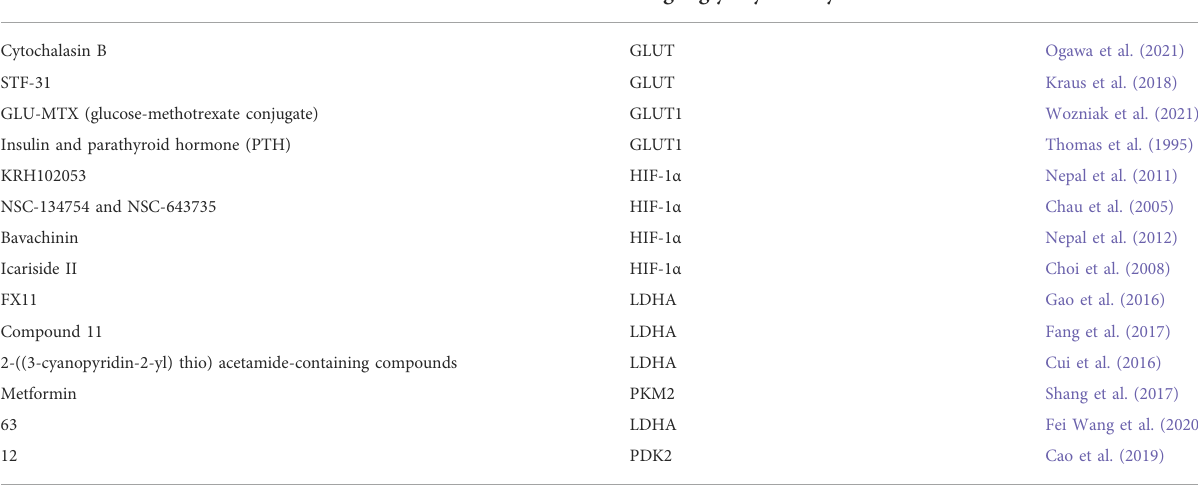
TABLE 1 List of glycolysis inhibitors that target OS cells.